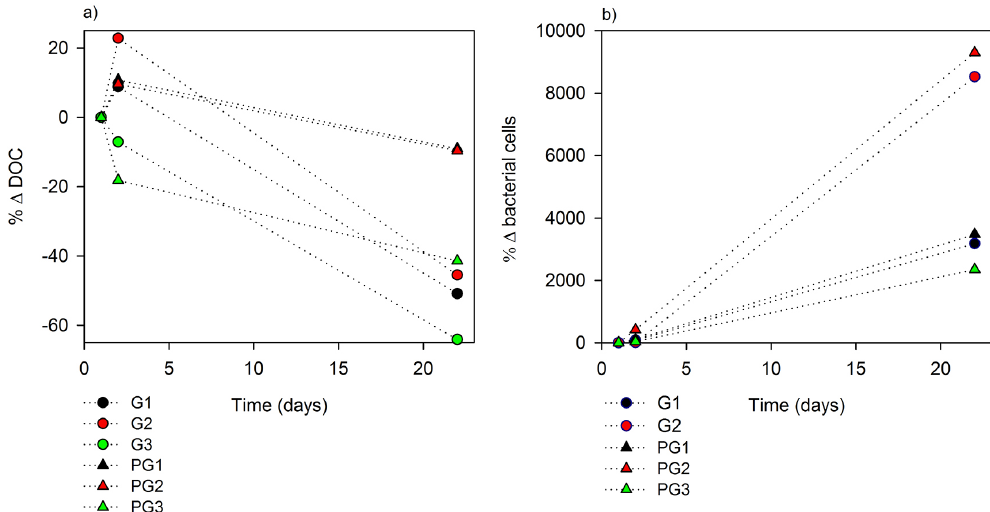
Figure 6. Mean % changes in (a) DOC and (b) bacterial abundance in bioavailability experiments containing proglacial (PG) or glacial (G) water and marine inoculum (filtered to 2.7µM). Each replicate is plotted separately.